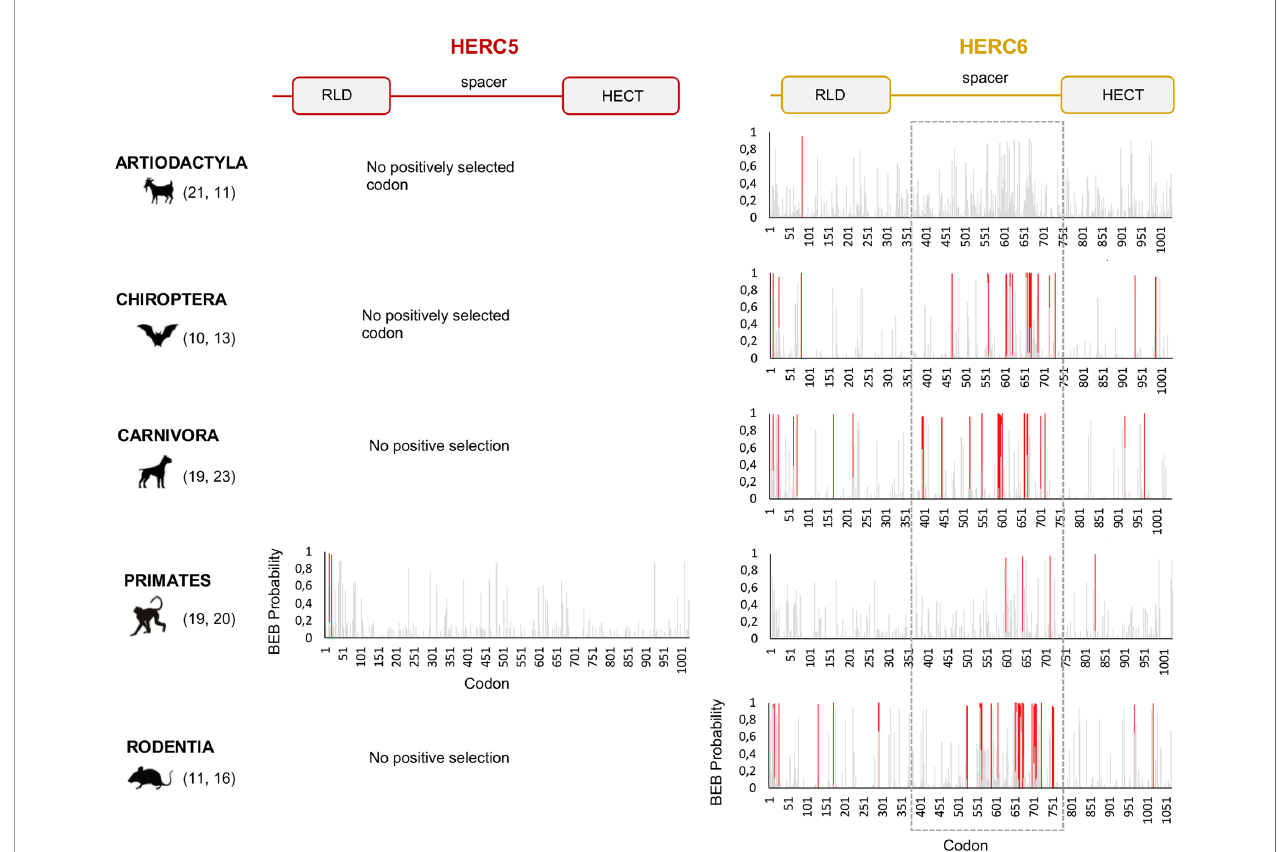
FIGURE 3 | HERC6 , and not HERC5 , has experienced strong and mammalian-wide positive selection. Graphic panels represent the posterior probabilities of positive selection (Bayes empirical Bayes, BEB) (y axis) in the M2 Codeml model (allowing for positive selection, w >1) for each codon (x axis) in HERC5 (left) and HERC6 (right) alignments. Red bars indicate the sites identi fi ed by both models, M2 and M8, with a BEB posterior probability greater than 0.95. Numbers in brackets are total species analyzed in each mammalian order for each gene. Site numbering is based on HERC5 protein sequences from Homo sapiens , HERC6 sequences from Bos taurus , Rhinolophus ferrumequinum , Felis catus , Homo sapiens , and Mus musculus . Above is a linear representation of HERC5 and HERC6 showing the structural domains, the RLD, spacer region, and HECT